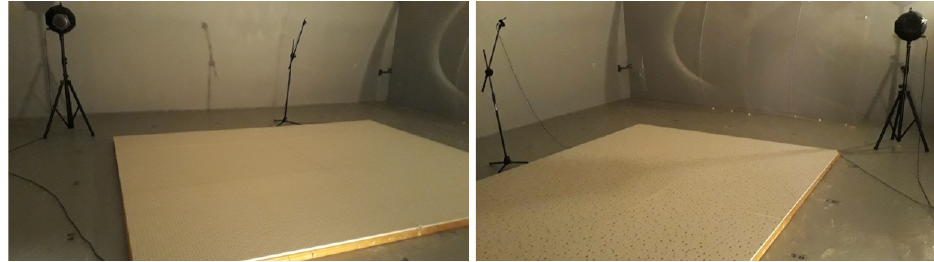
Figure 8. Sound absorption tests in the reverberation chamber of the EPSG–UPV.